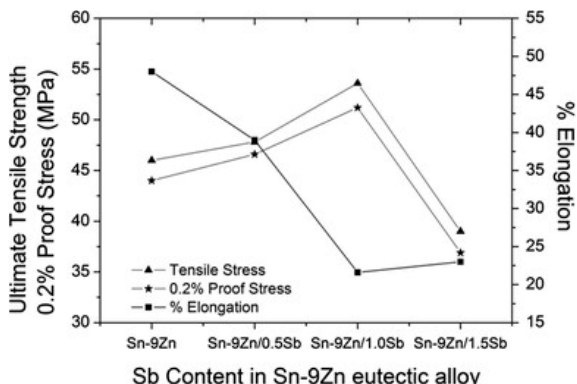
Figure 13. Effect of Sb nanoparticles on the tensile properties of the Sn–9Zn–xSb composite solders (x